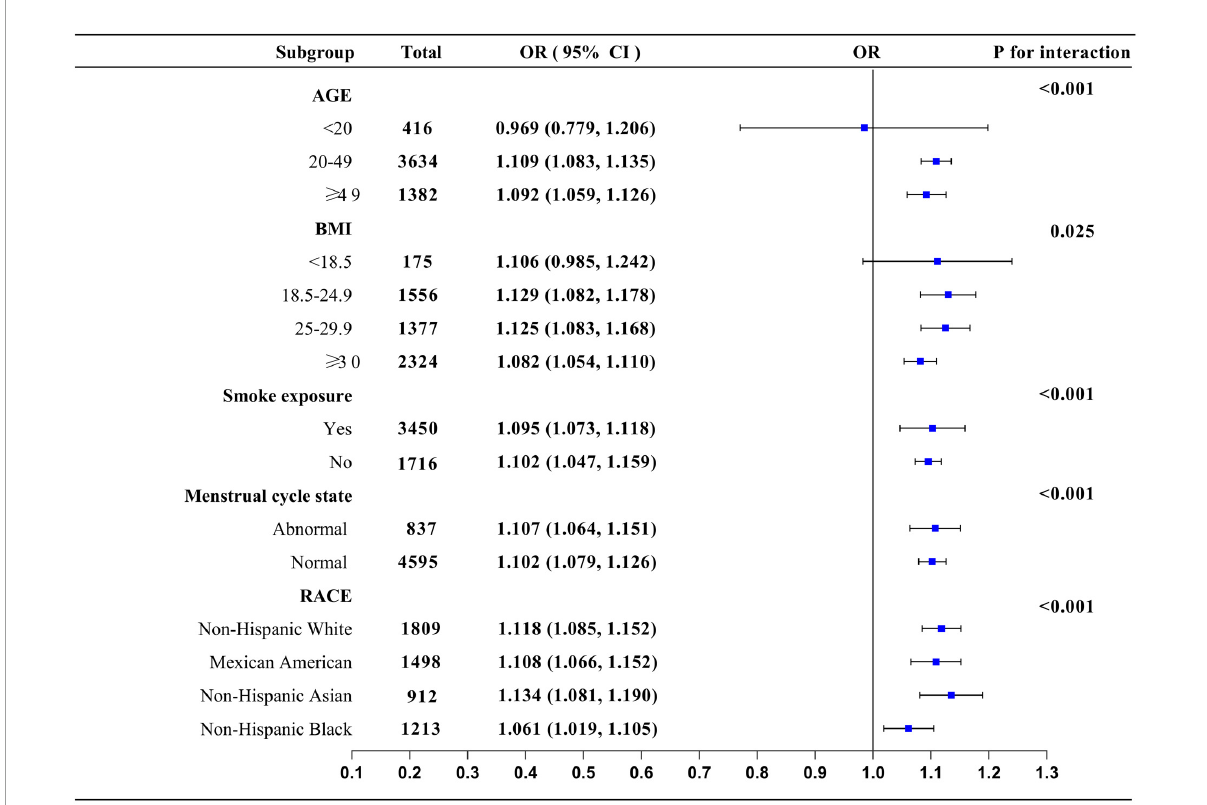
FIGURE5 Subgroup analysis: Forest plot showing the OR and 95%CI of incidence of pelvic inflammatory diseases risk in patients with different degrees of depression in different subgroups.